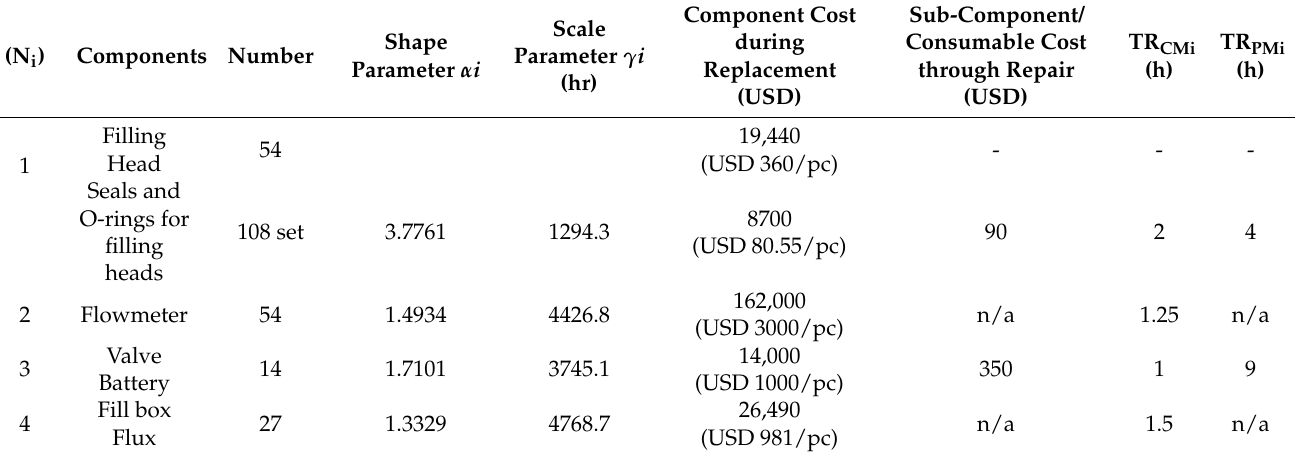
Table 1. Parameters of maintenance for filling machine